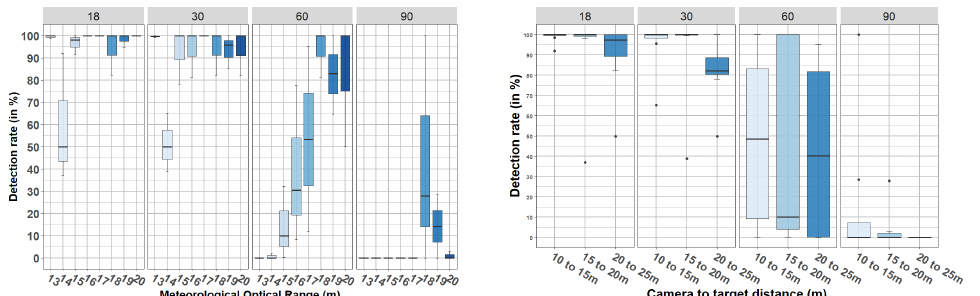
Figure 24. Detection rate (in %) obtained during dynamic scenarios—targets in motion—pedestrian detection.